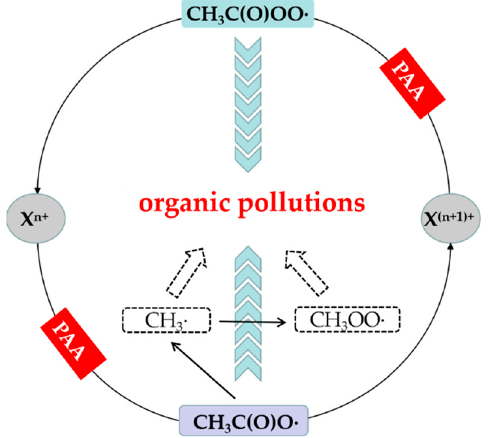
Figure 3. Transition metal/PAA reaction scheme.